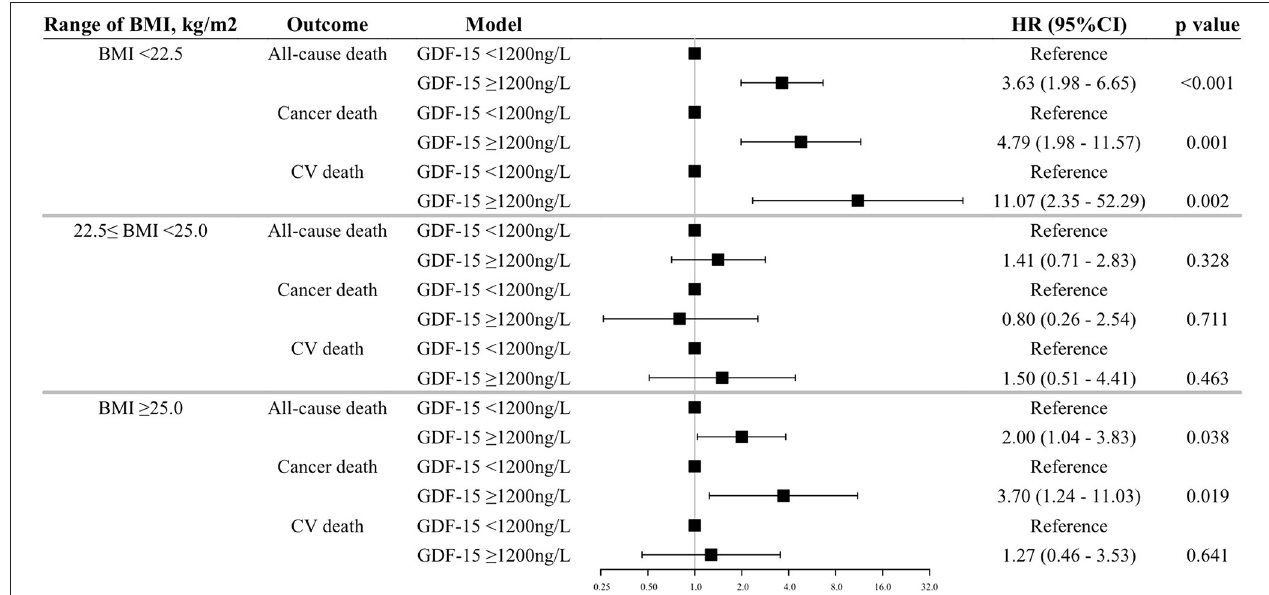
FIGURE 4 | Association between elevated GDF-15 and outcomes in the BMI subgroups. Shown are the results of a Cox proportion hazard analysis by a dichotomous model of GDF-15 and outcomes adjusted for traditional risk factors. The BMI subgroups were stratified based on the cut-off points of 22.5 and 25.0 kg/m 2 (i.e., < 22.5 as low BMI, 22.5–25.0 as normal BMI, ≥ 25.0 as high BMI). Adjustments of the Cox model are as shown in Figure 1 . GDF-15, growth differentiation factor-15; BMI, body mass index; CV death, cardiovascular death.